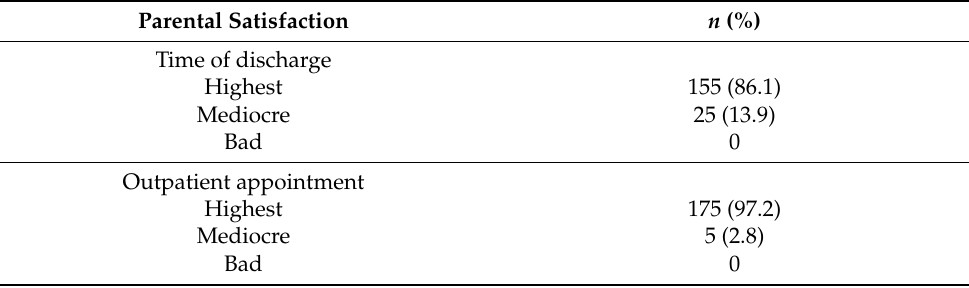
Table 5. Parental satisfaction evaluation.